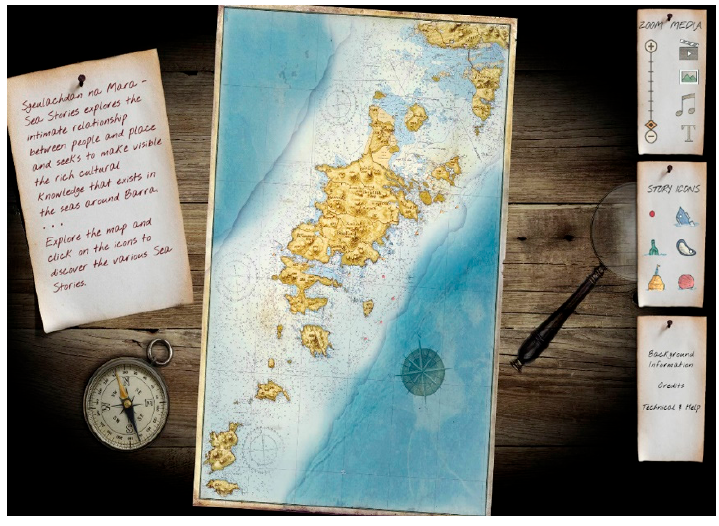
Figure 2. Sea Stories online cultural map of the sea (Hurrel and Brennan 2013).